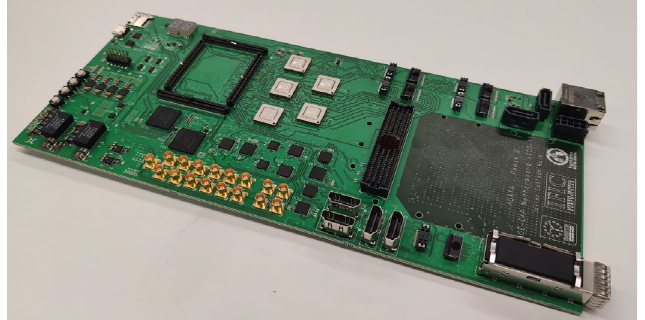
Fig. 2. The motherboard implementation version PACE-CAP, it is the final solution for AGATA Phase 2 electronics in combination with STARE board and the FPGA